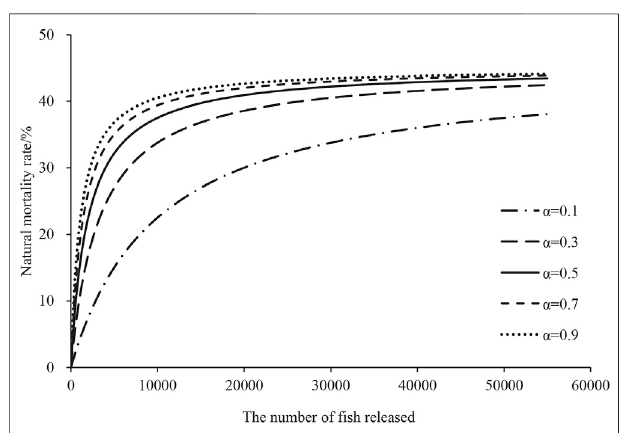
FIGURE 1 | The relationship between the natural mortality rate and the number of fi sh released based on a density-dependent theory. α is the constant of the speci fi c